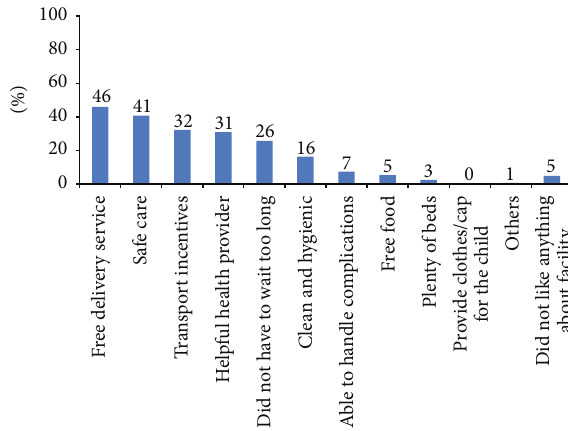
Figure 2: Maternity clients’ likes about delivery care ( 𝑁 = 447 ).